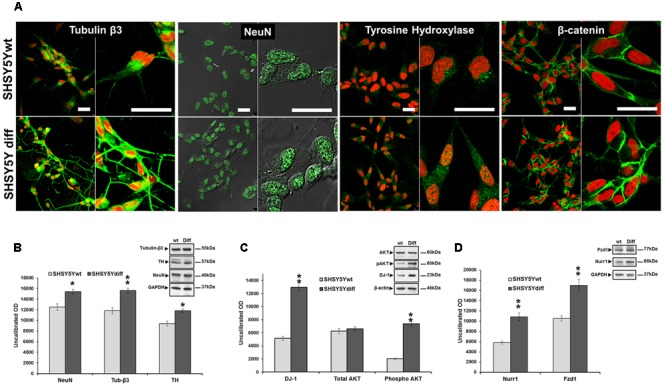
Comparative analyses of phenotypical features in SHSY5Ywt and SHSY5Ydiff cells. (A) Confocal microscopy showing the intracellular distribution of Tubulin-β3, NeuN, TH and β-catenin in basal and RA-differentiated SHSY5Y cultures. For Tubulin-β3, TH, and β-catenin immunostaining, cell nuclei were counterstained with propidium iodide (red hue); for NeuN, cell morphology was visualized by differential interference contrast (DIC) and merged images NeuN/DIC are shown. Bars: 25 μm. (B–D) WB and densitometric analyses of the expression levels of Tubulin-β3, NeuN and TH, Nurr1 (neuronal and DA neuron specific markers), DJ-1 and phospho-AktT308 (neuronal survival factors involved in neuroprotection against oxidative stress), and Fzd1 (Wnt pathway related molecule), in SHSY5Ywt and SHSY5Ydiff cells. Values from all densitometric analyses were normalized to β-actin or GAPDH. Significance SHSY5Ydiff vs SHSY5Ywt (Student’s t-test): ∗p < 0.05; ∗∗, p < 0.01; the mean ± SD; n = 3.